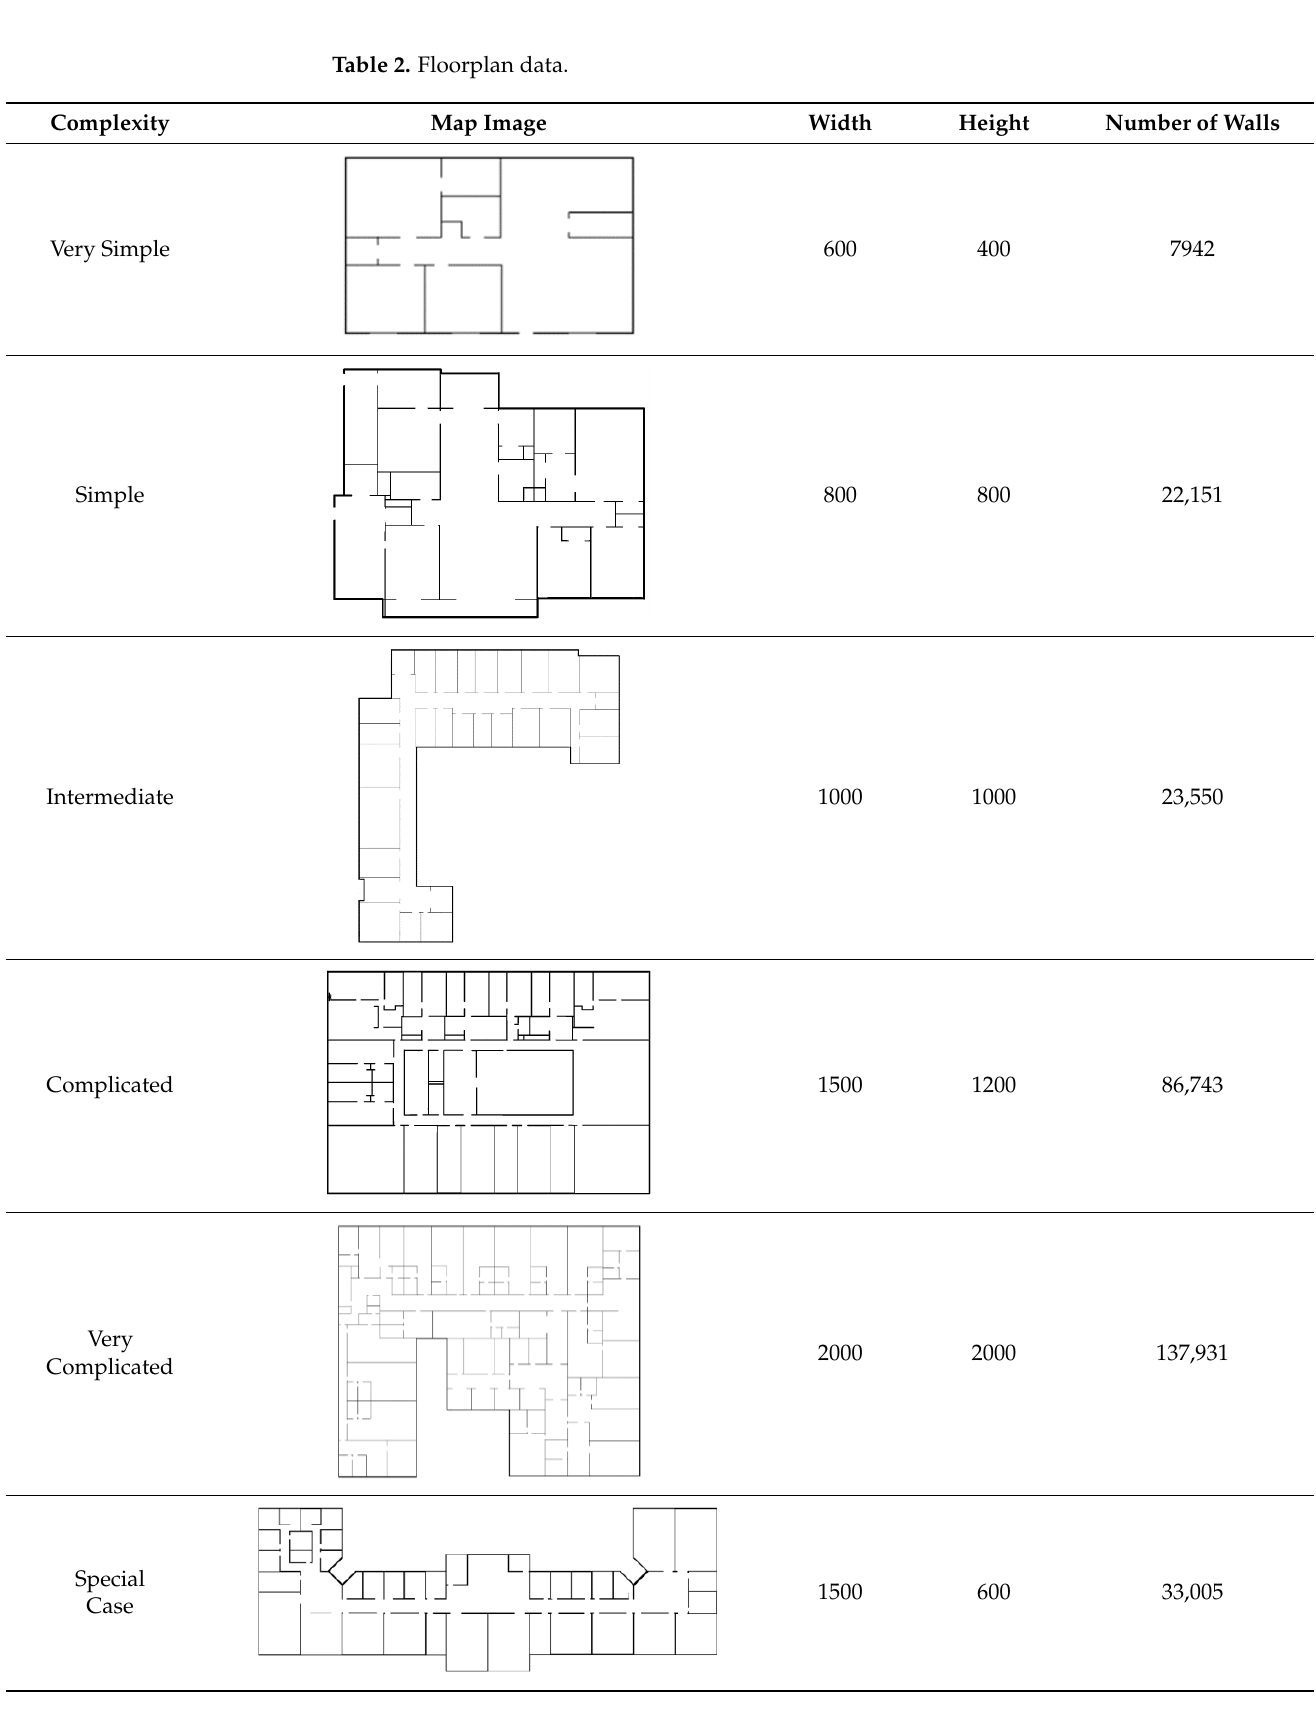
Table 3. Experimental